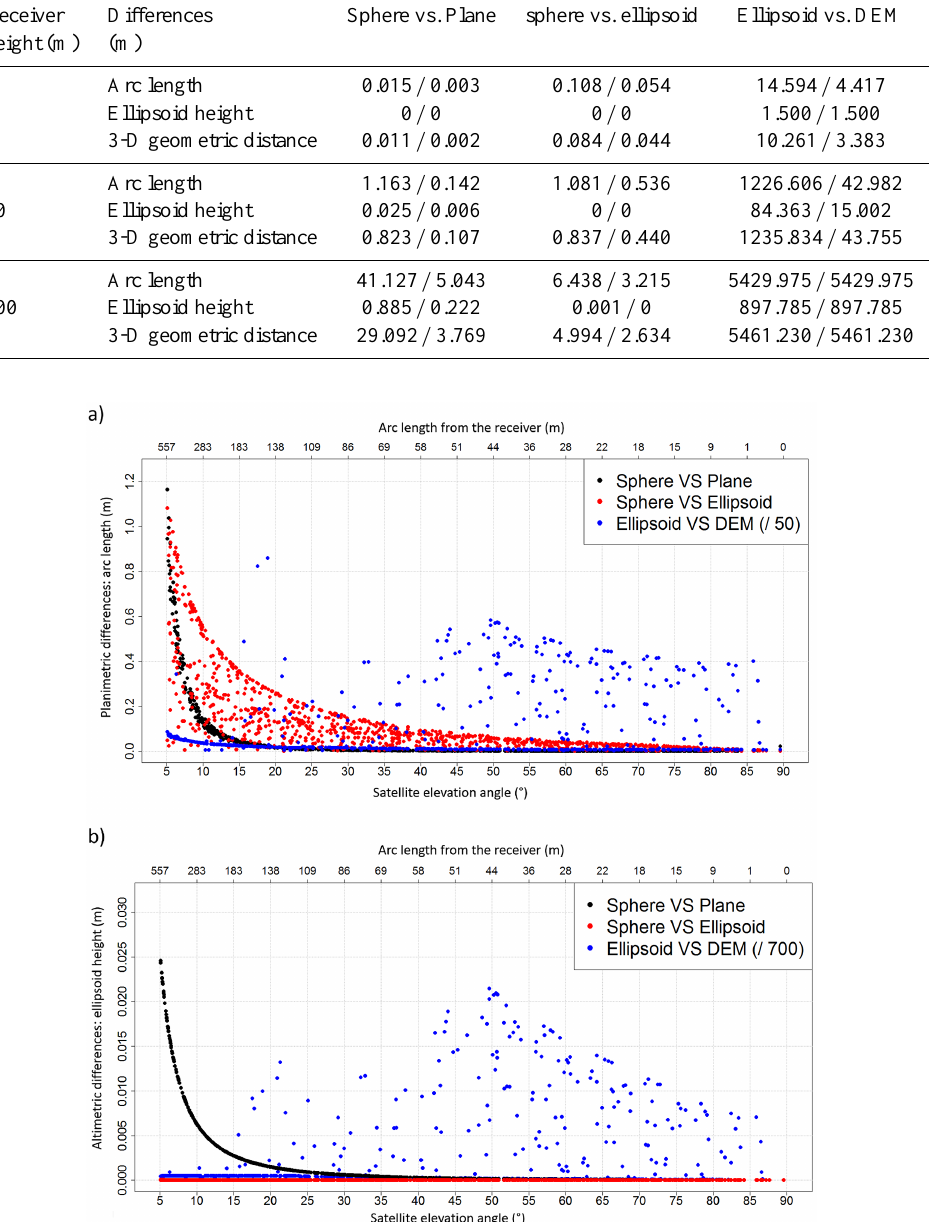
Figure 12. Planimetric and altimetric differences between the specular reflection points obtained with the different algorithms. Receiver height above the reflecting surface: 50m. (a) Planimetric differences as arc length (m). (b) Altimetric differences as ellipsoid height (m). Note the dispersion within results for a fixed elevation angle, which is a consequence of the azimuth variability in the ellipsoidal radius of